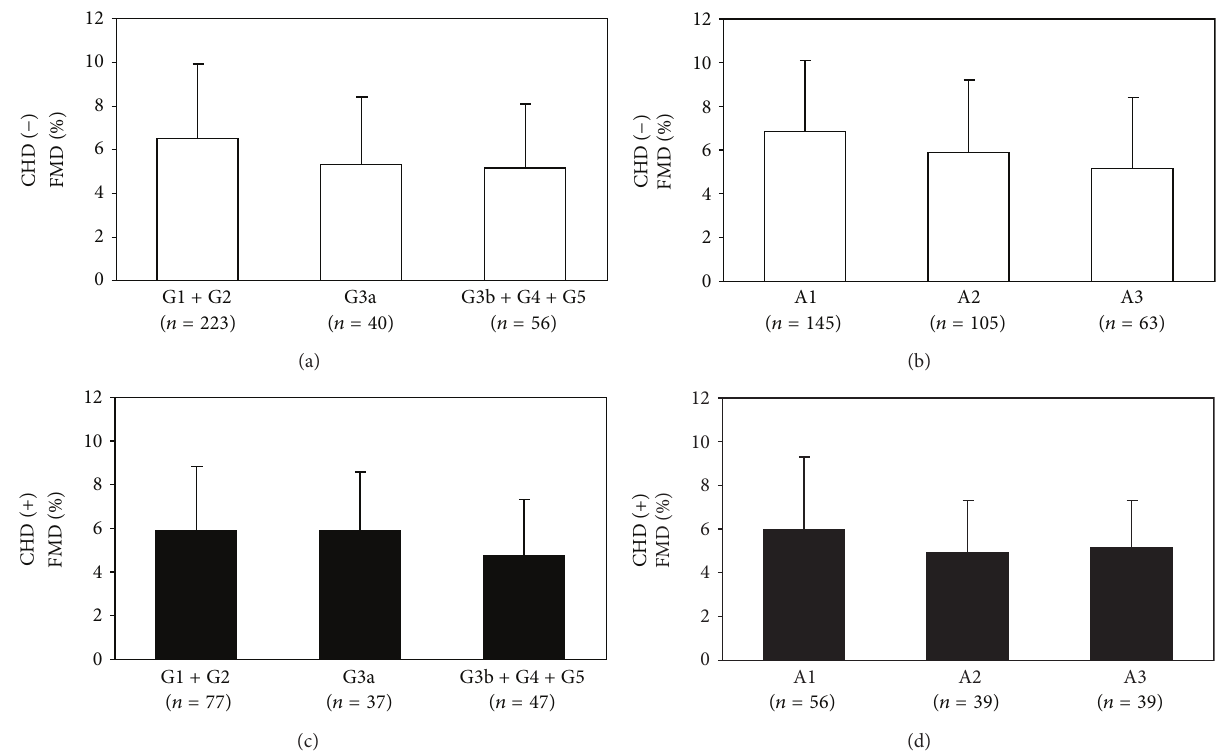
Figure 3: The comparisons of the FMD among (a) GFR stages and (b) albuminuria stages in the patients without CHD and among (c) GFR stages and (d) albuminuria stages in the patients with CHD in the group with type 2 diabetes